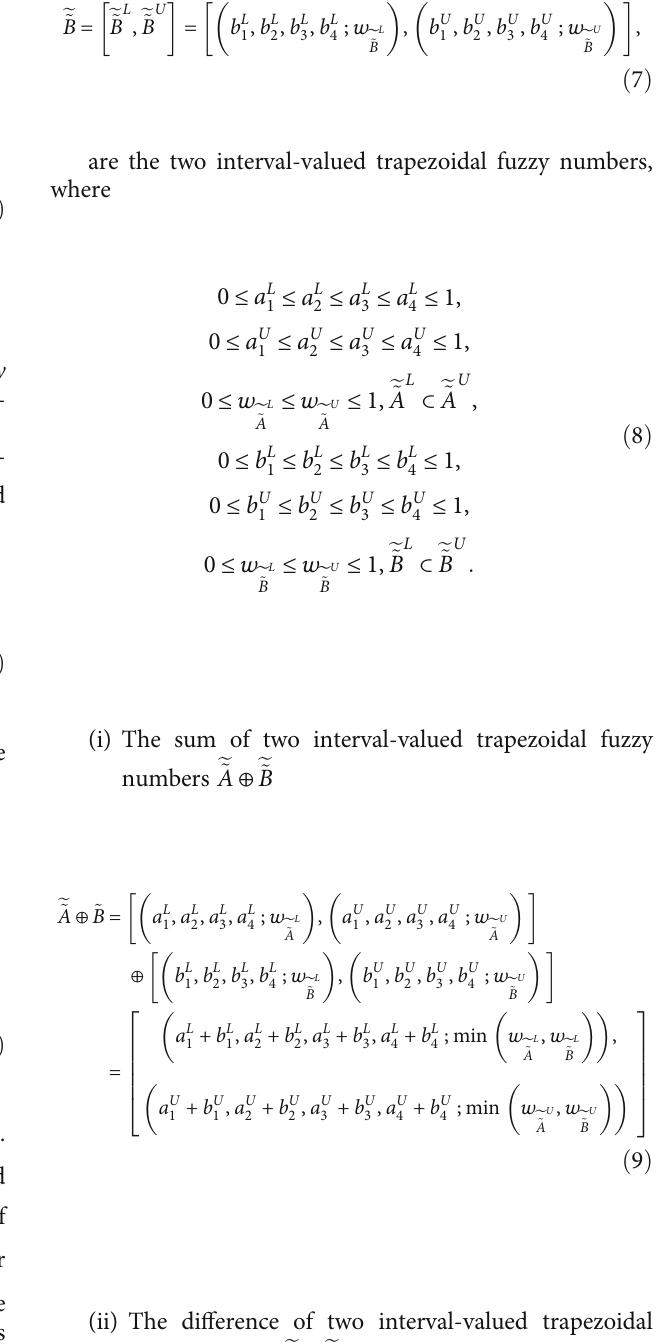
Figure 2: Trapezoidal fuzzy number ~ A